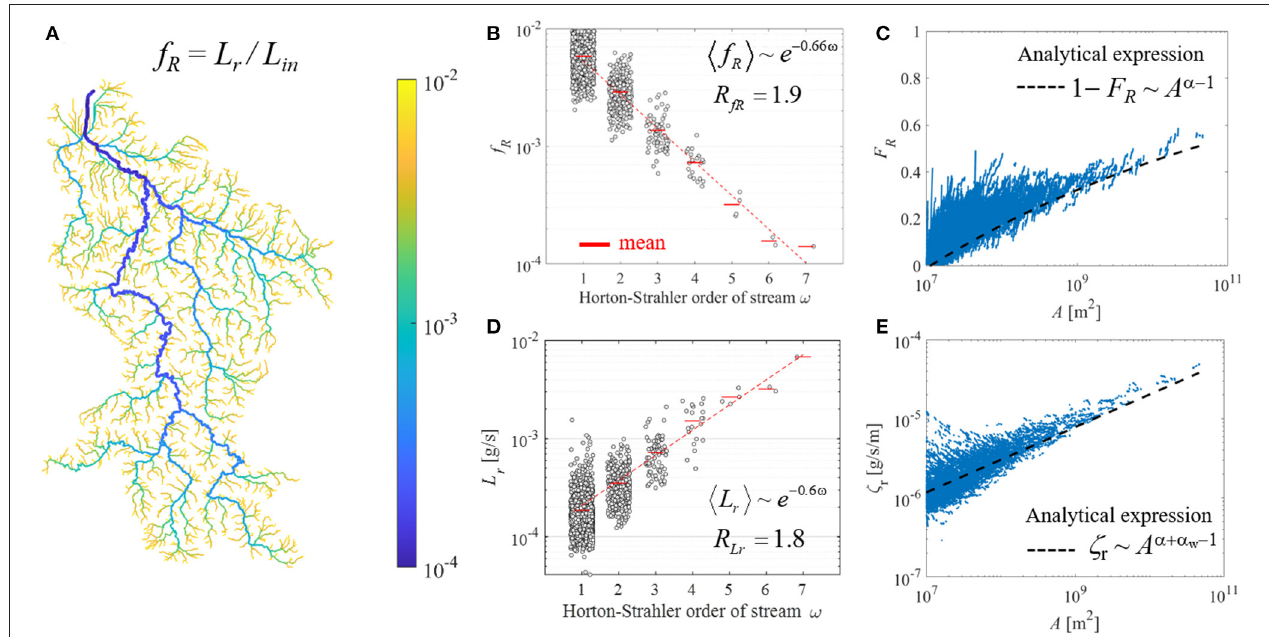
FIGURE 4 | Distributions of the removed P tot loads along the Weser River network under the mean river discharge. (A) Entire basin-scale distribution for the fraction f R of P tot loads removed in each reach ( L r ) to input mass flux to the same reach ( L in ). (B) Stream-order ω based distribution for f R . (C) Distribution of the fraction of total P tot loads removed by upstream catchment F R at a given drainage area A . (D) The ω -based distribution for L r . (E) Distribution of removed P tot loads per unit length in each reach, ζ r , over A . For visual efficiency, values of gray dots in (B,D) were extracted from the most downstream point of each stream for a given ω . Hortonian scaling equation and the corresponding scaling ratio are in (B,D) . Blue dots in (C,E) indicated the model results for each stream reach of the Weser River network. Dashed black line in (C) and (E) was plotted by following the analytical scaling of Equations (12) and (10) derived in Bertuzzo et al. (2017), respectively. Following the original framework, the exponent α = 0.91 was fitted from scaling of input mass flux only from diffuse-sources over drainage areas. The other exponent α w = 0.5 came from the hydraulic geometry scaling between width and river